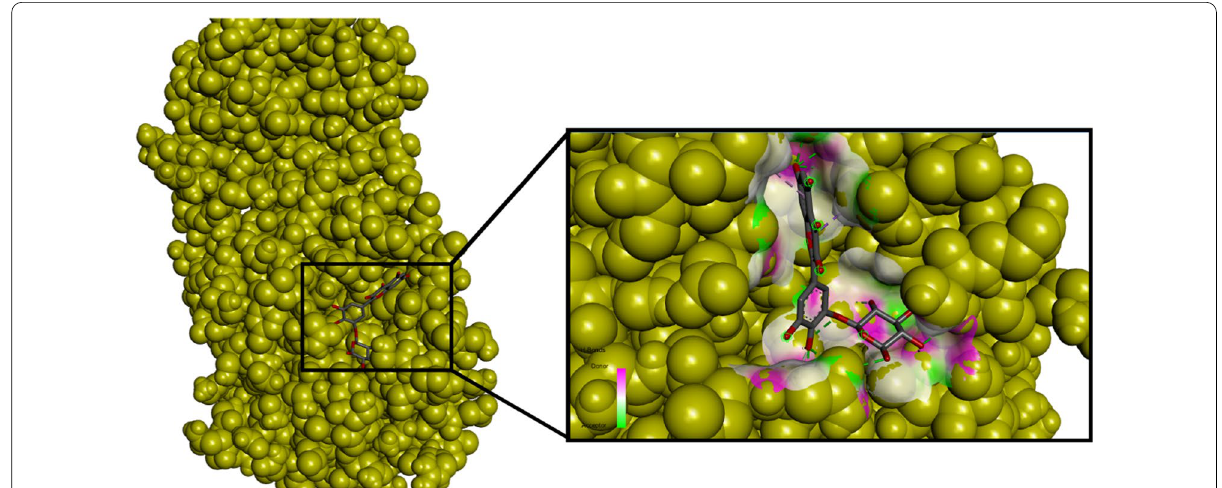
Fig. 1 Binding pocket of SARS-CoV-2 main protease (6YNQ) with quercetin 3 ′